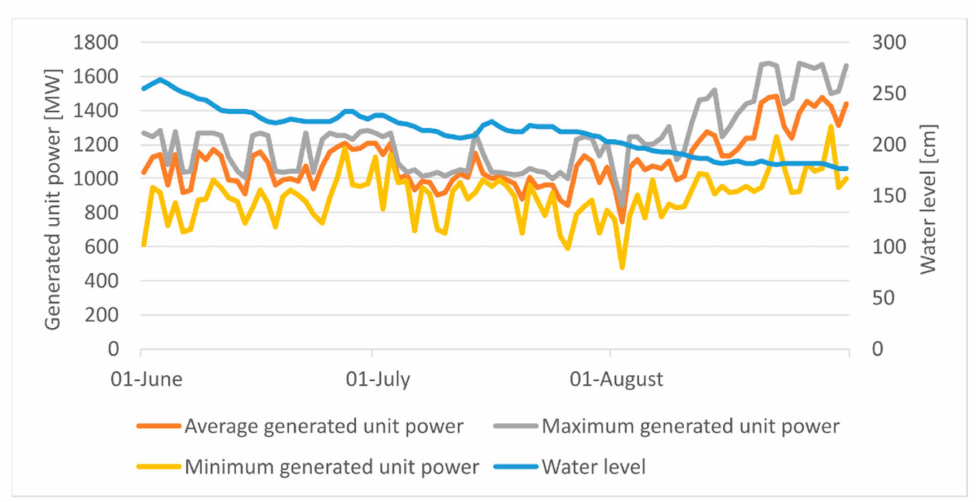
Figure 13. Diagram of the average daily water level in the Wisła River (Szczucin) with the minimum, average, and maximum daily power generated in the Połaniec power plant.